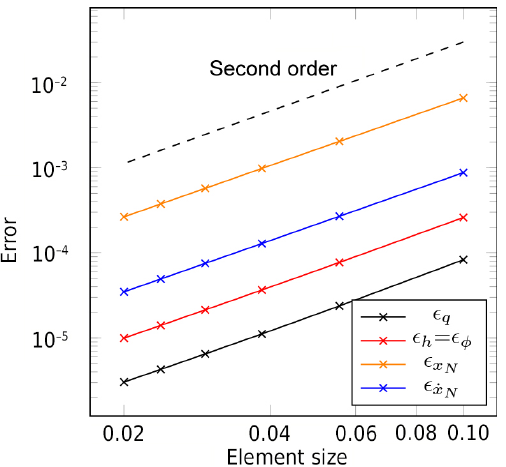
Figure 3. Similarity convergence analysis. All variables are shown to converge on the correct solution at the correct order. (cid:15) ( ∗ ) indicates the L 2 norm of the error in the solution obtained for variable ( ∗ )